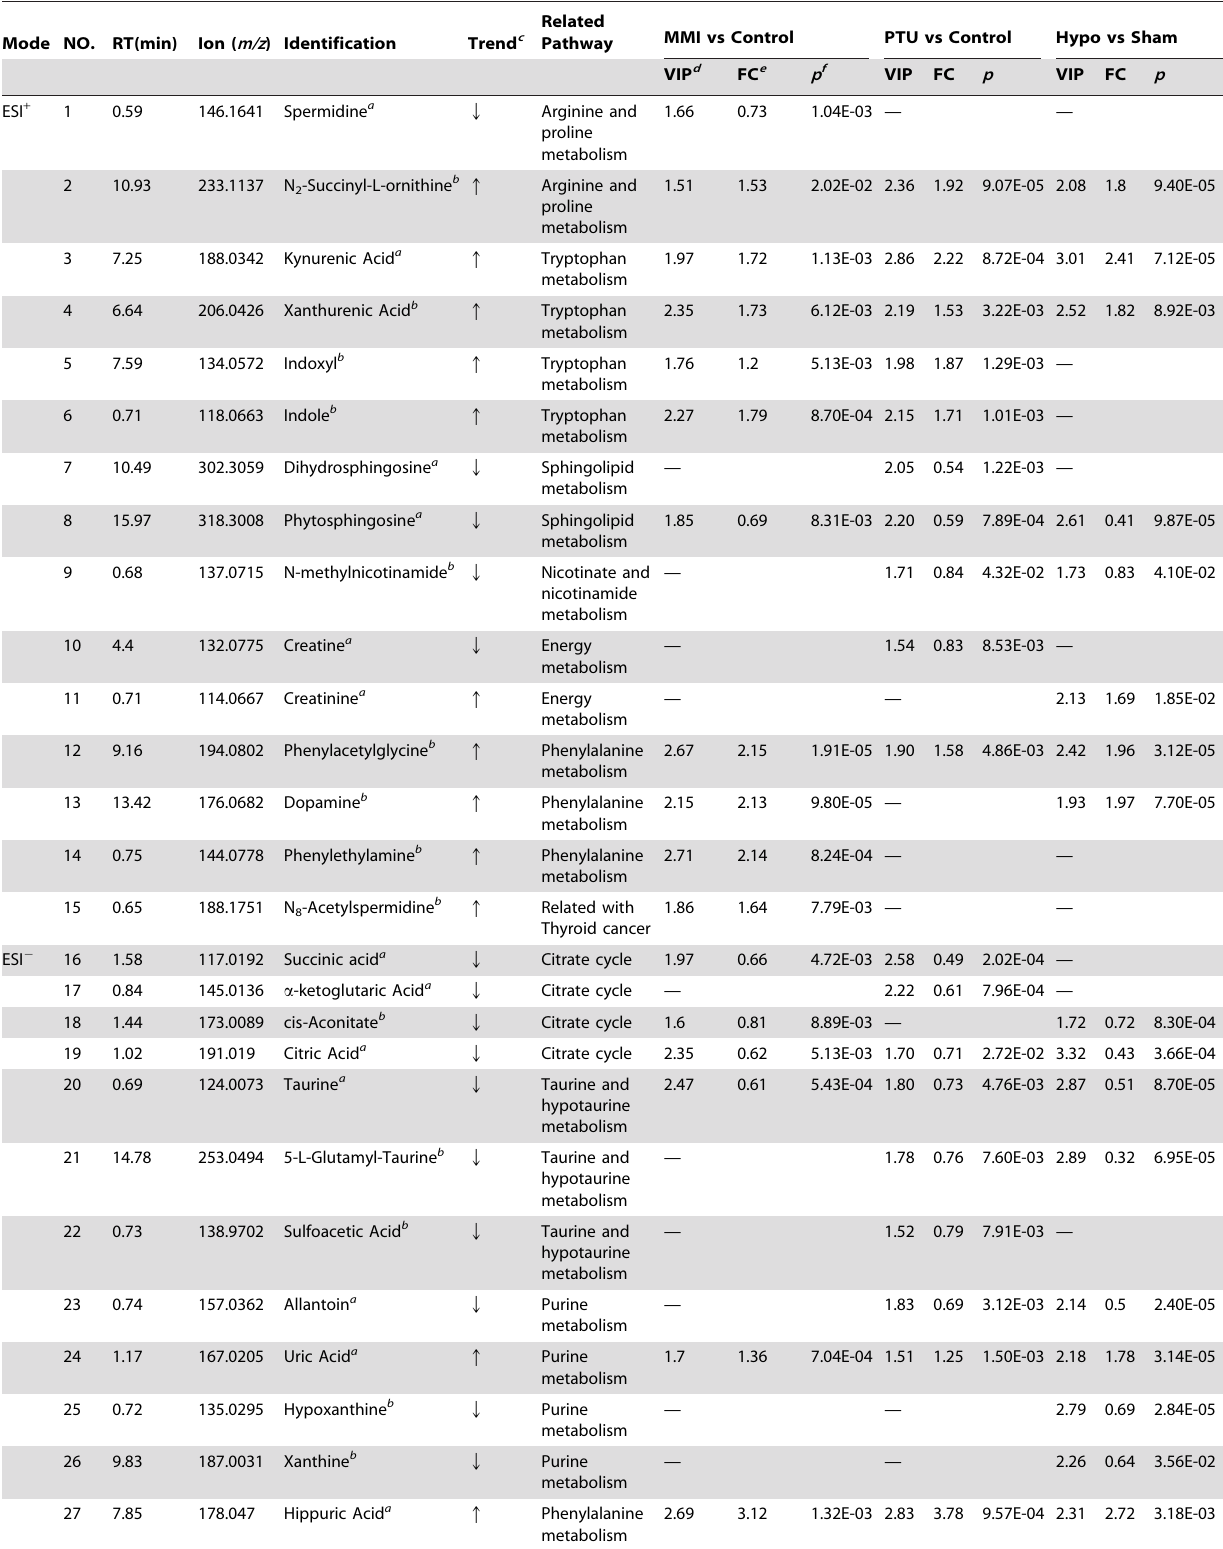
Table 4. Potential Biomarkers and their Metabolic